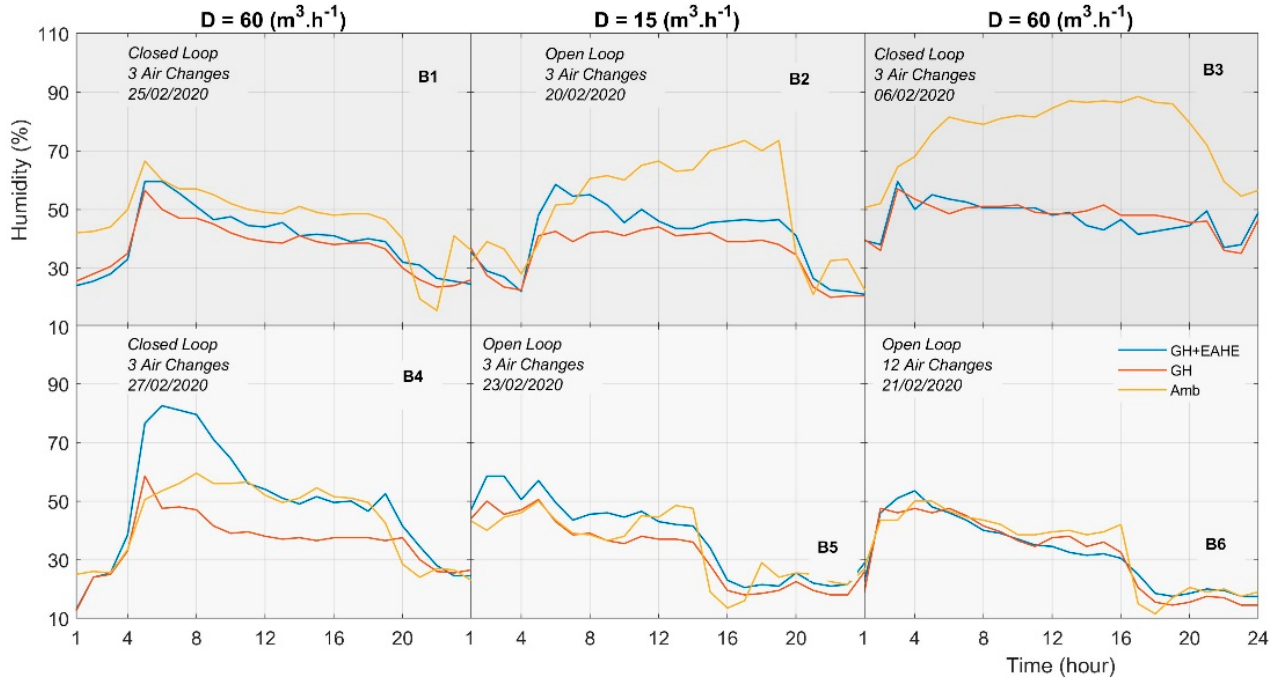
Figure 6. GHs air humidity variation during the experiences periods (heater device: On).